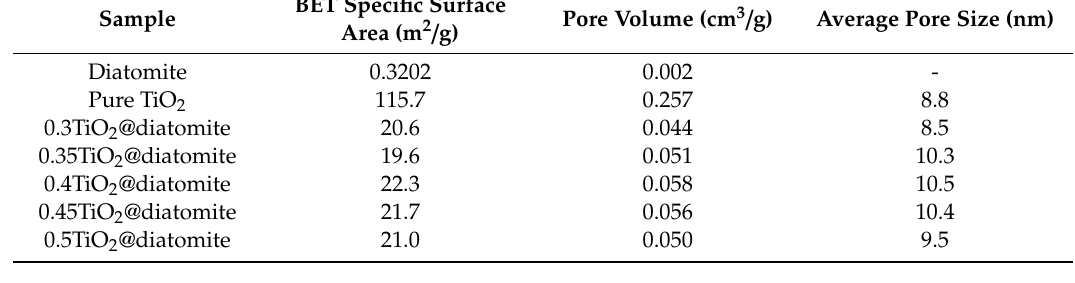
Table 2. Surface and structural characterization of the catalysts.